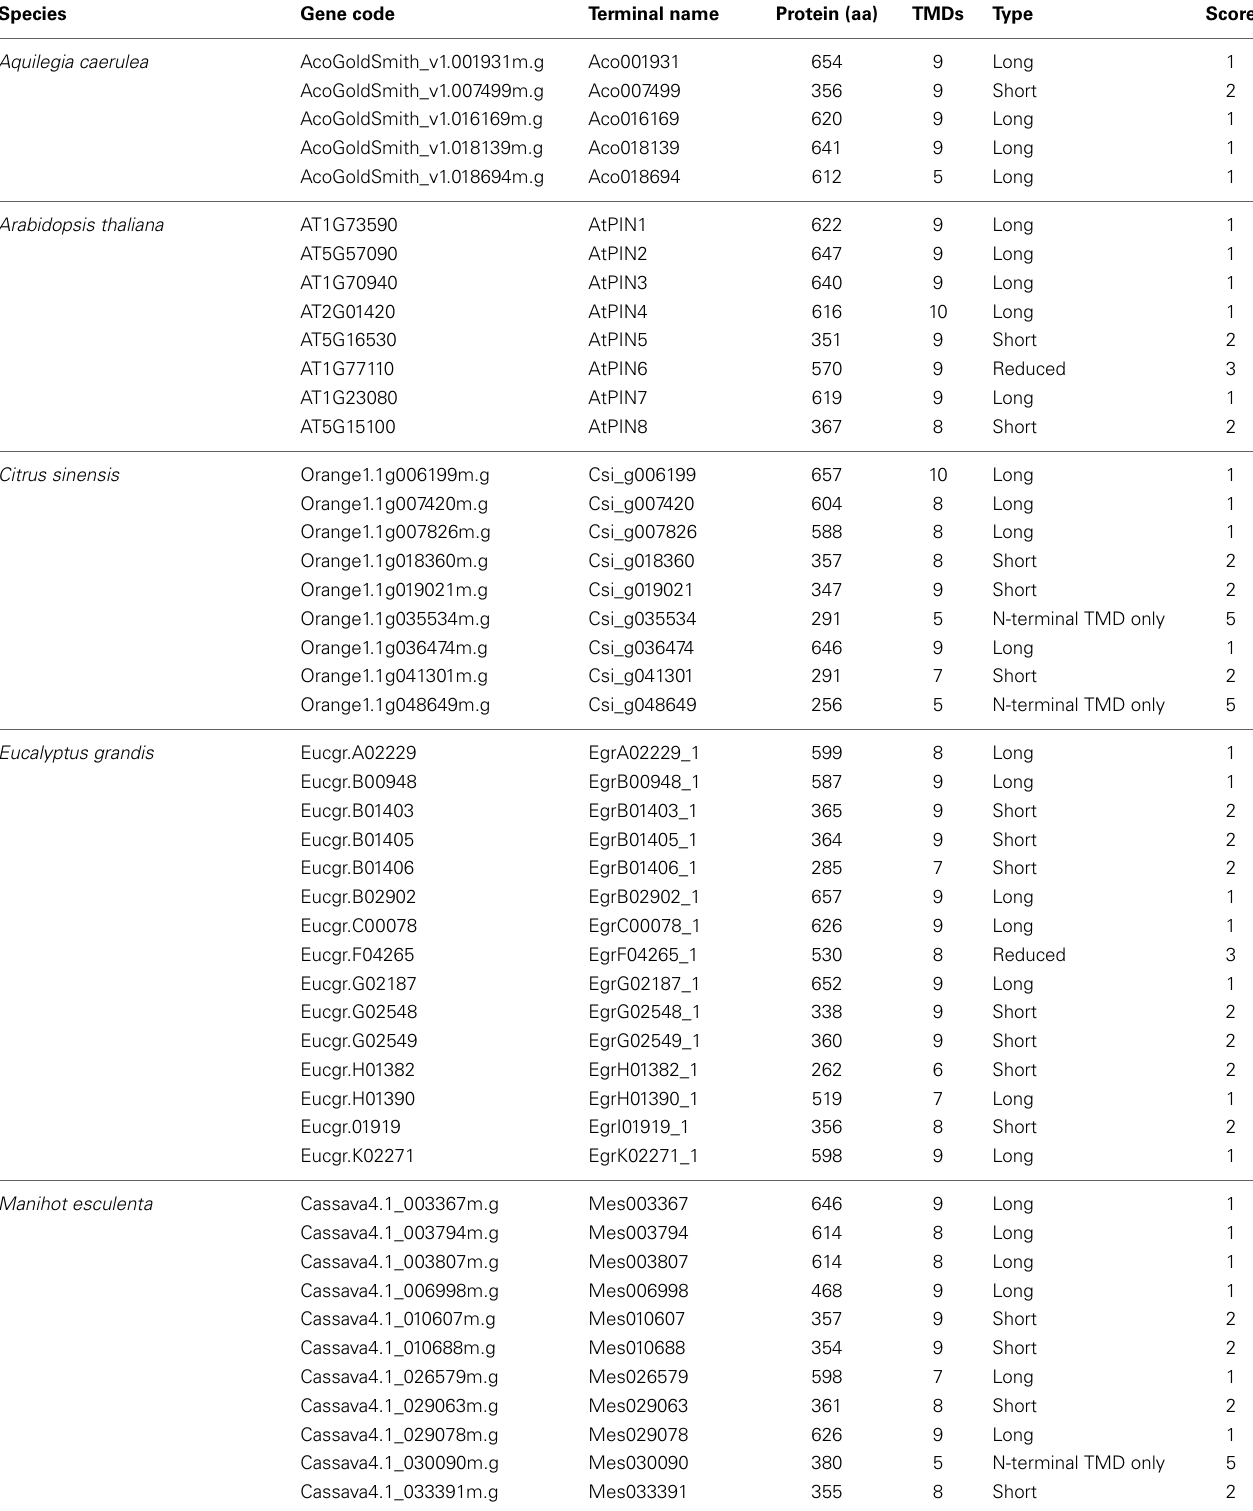
Table 1 | PIN genes analyzed in this